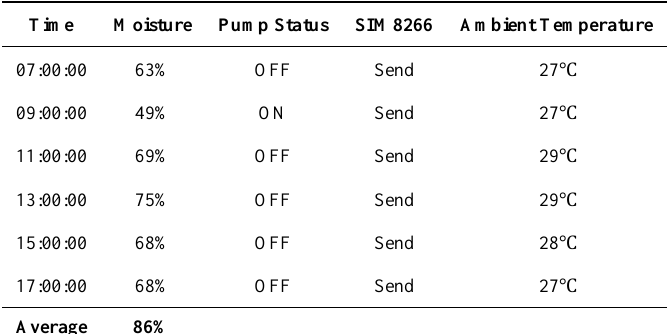
Figure 8. (a) Graph of Moisture Level; (b) Graph of Room temperature level. Table 1. Testing of soil moisture control during cloudy